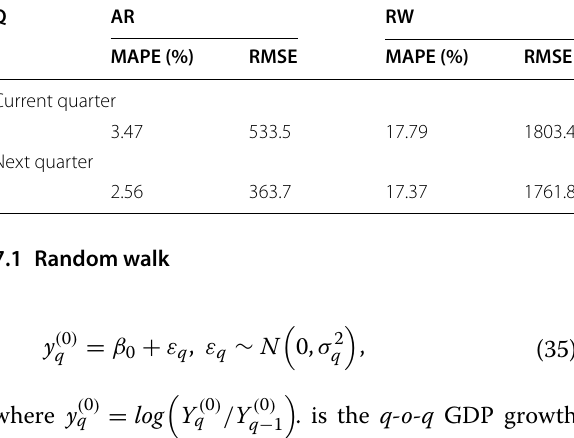
Table 7 MAPE and RMSE loss functions for government spending on public goods and services